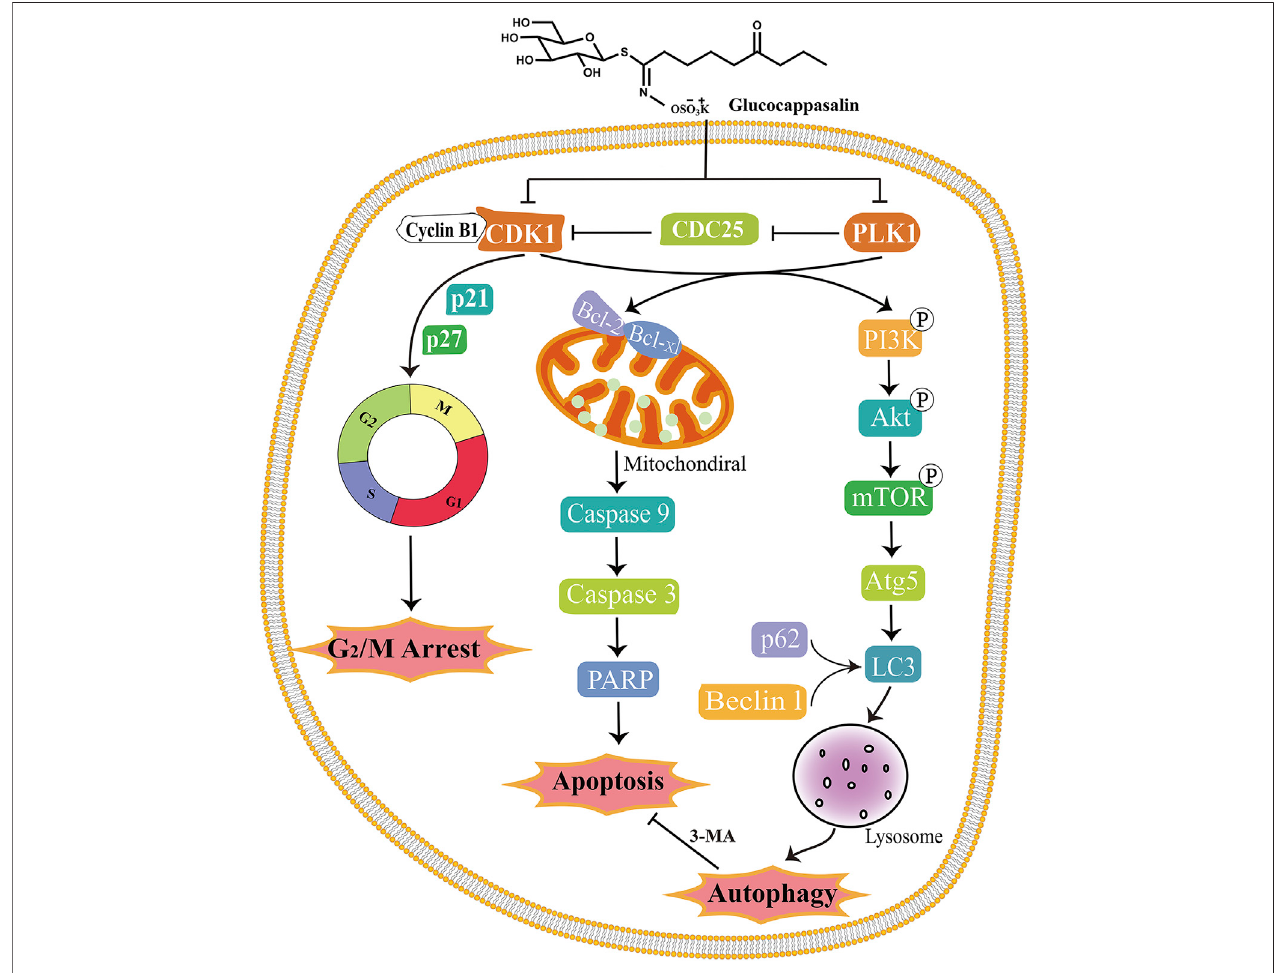
FIGURE 9 | Schematic model of the molecular mechanisms illustrating how GCP induces G2/M arrest, apoptosis and autophagy in HeLa cells. After treatment, GCP suppresses the CDK1 and PLK1, leading to cell cycle arrest at G2/M phase, mitochondrial apoptosis, and autophagy via PI3K/Akt/mTOR signaling pathway.